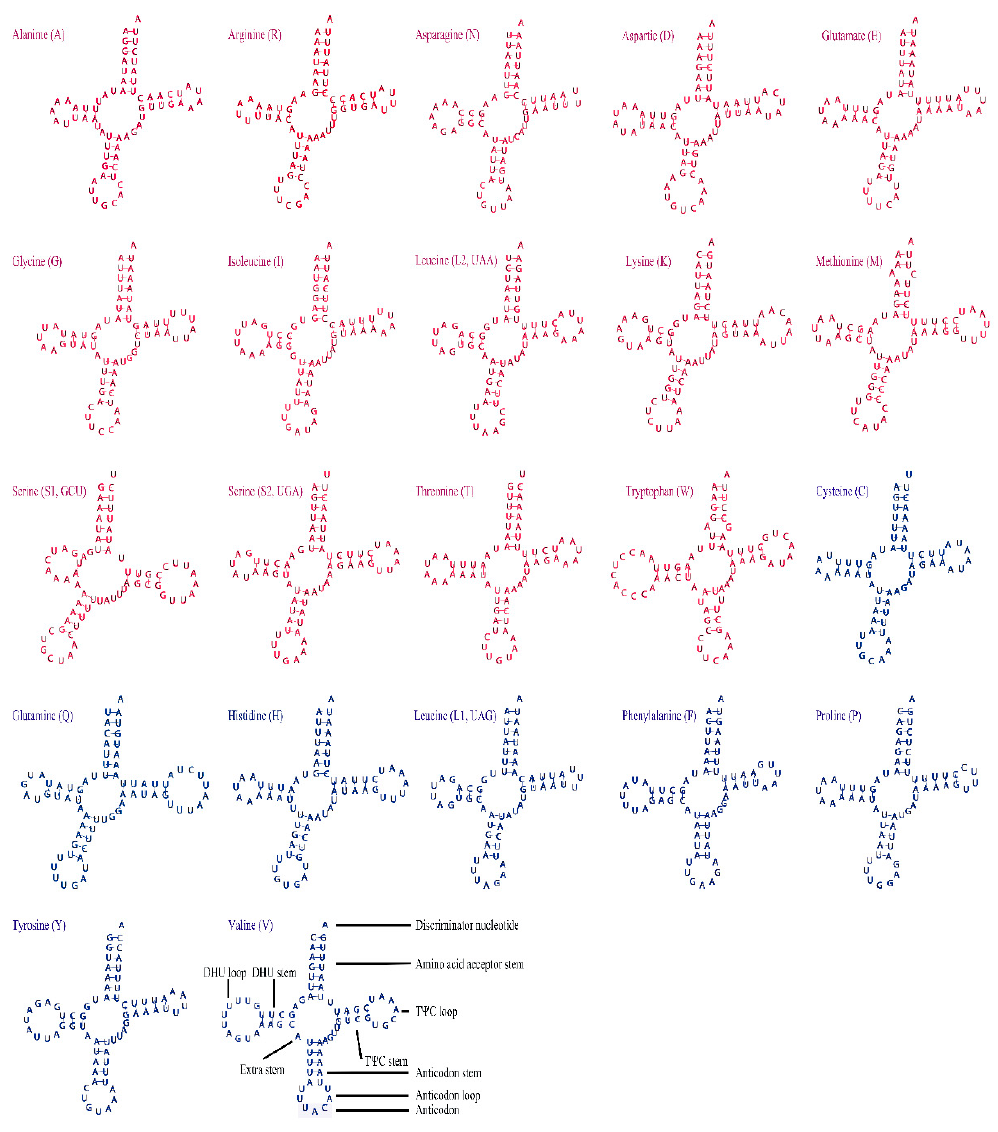
Figure 4. Secondary structure of 22 tRNAs in the H. sinicus . The tRNAs located on the J-strand are dark red, while those located on the N-strand are dark blue.